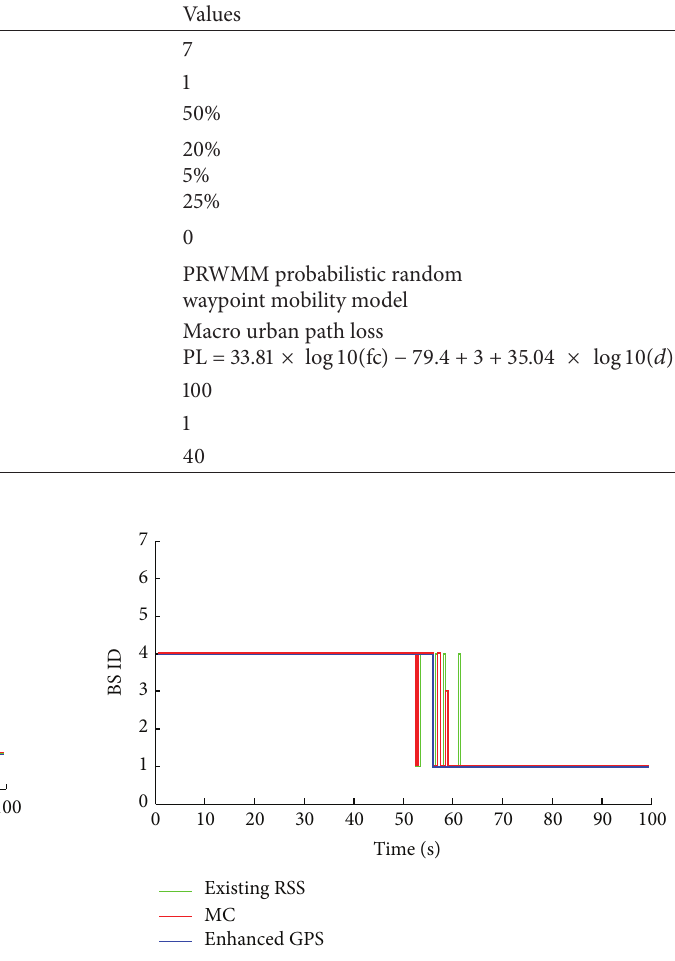
Figure 8: BS prediction without FRR3.